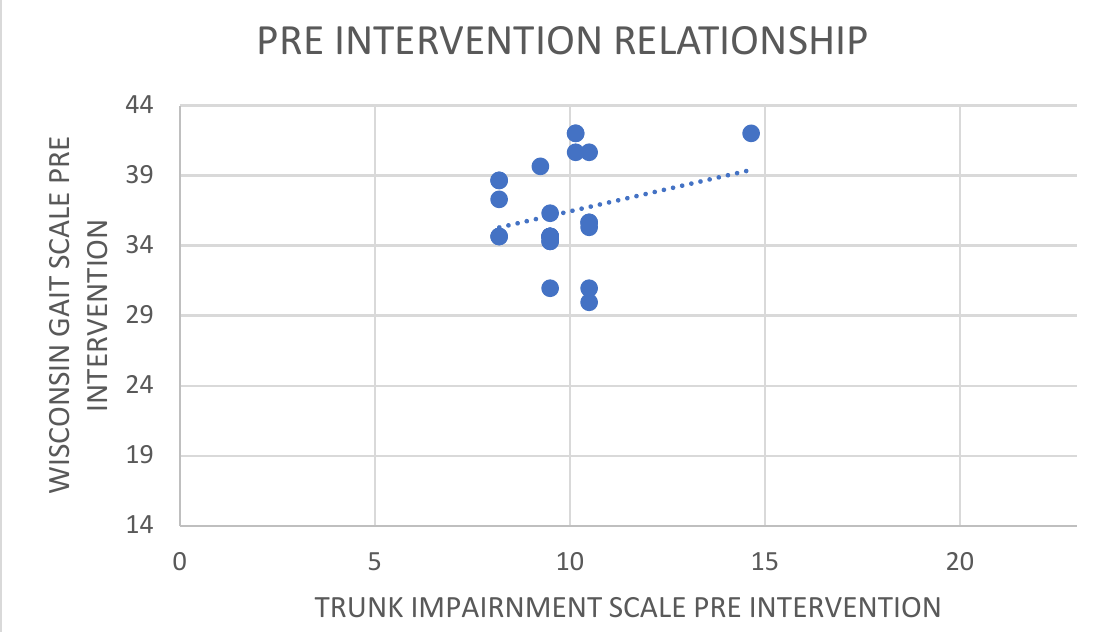
Figure 6. Relationship between pre trunk impairment scale and pre Wisconsin gait scale (weak positive correlation).